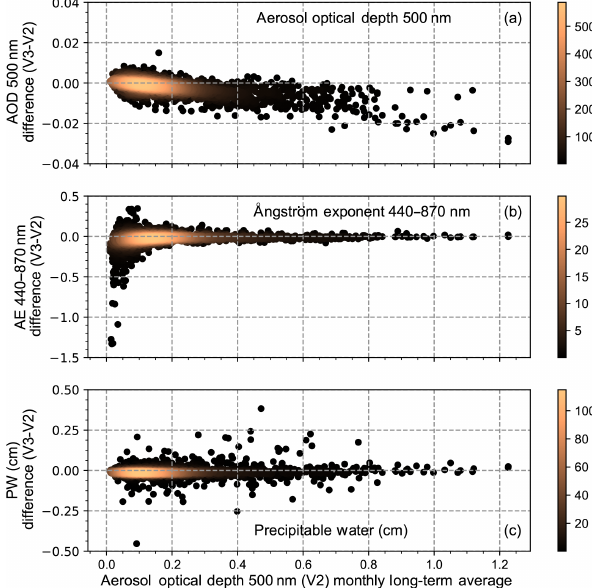
Figure 21. Comparison of Version 3 and Version 2 Level 2.0 multi- year monthly average data sets. (a) The aerosol optical depth (AOD) interpolated to 500nm to include data from instruments without 500nm. (b) The Ångström exponent (AE) is calculated utilizing the inclusive ordinary least-squares regression fit from 440 to 870nm. (c) The precipitable water in centimeters is derived from the 935nm water vapor channel. (d) The difference in the number of days is de- termined for each monthly long-term average.